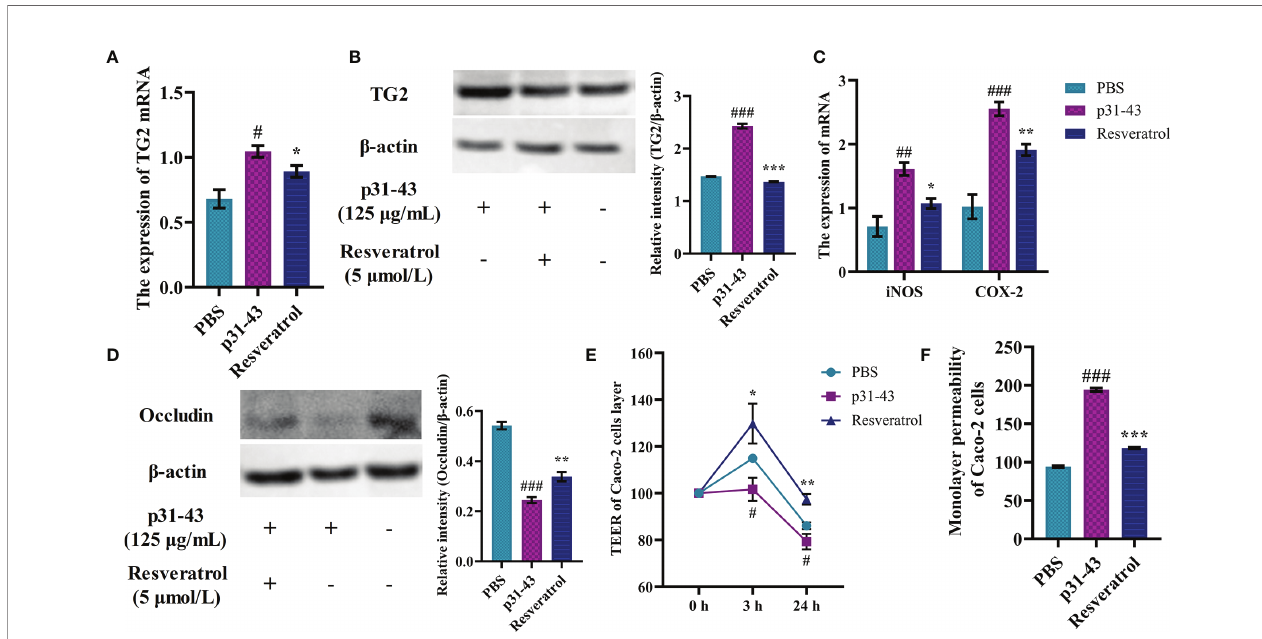
FIGURE 2 | Resveratrol regulated celiac disease-related indicators in Caco-2 cells. (A) The expression of TG2 gene. (B) The expression of TG2 protein. (C) The expression of iNOS/COX-2 gene. (D) The content of Occludin protein. (E) Monolayer resistance values of Caco-2 cells. (F) Monolayer permeability of Caco-2 cells. # Indicated statistically signi fi cant differences when compared to the PBS group. # P < 0.05; ## P < 0.01; ### P < 0.001. * Indicated statistically signi fi cant differences when compared to the p31-43 group. *P < 0.05; **P < 0.01; ***P <